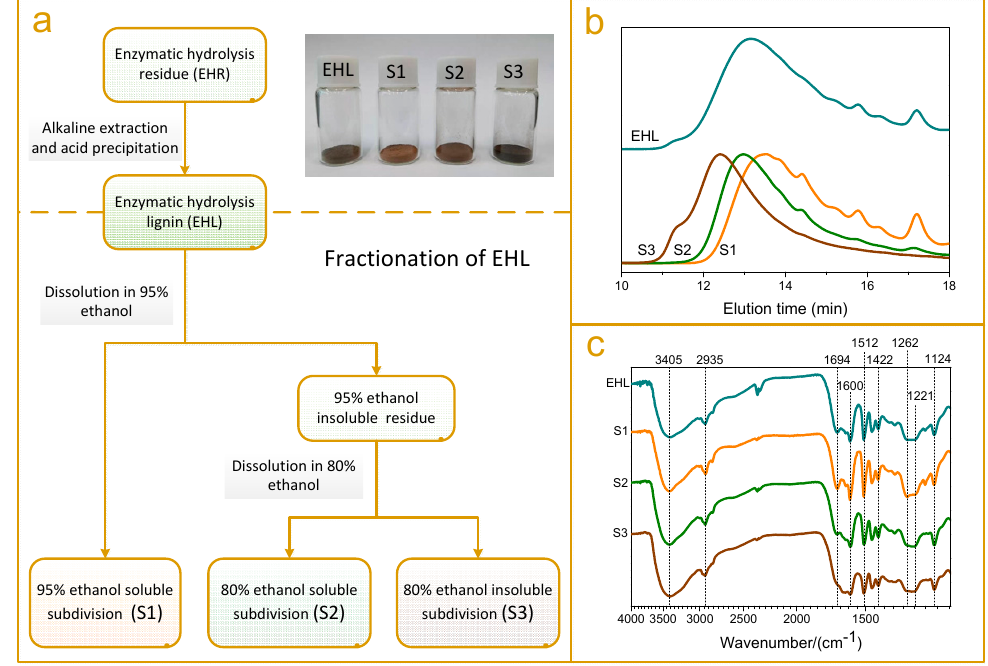
Table 1. Yield, molecular weight distribution, specific surface area and Zeta potential of lignin subdivisions, as well as those of enzymatic hydrolysis lignin (EHL).